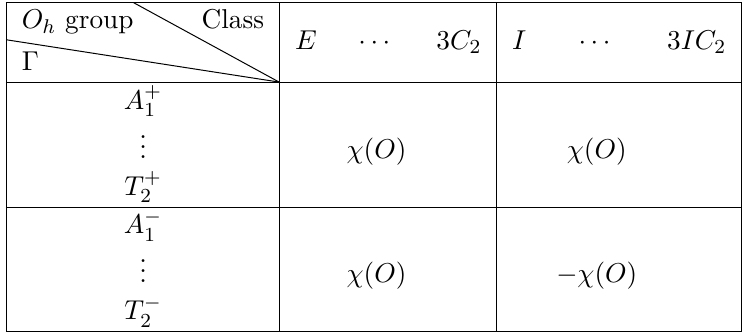
Table 7 . Character table for the O h group. χ ( O ) stands for the character table of the O group given in table 6.